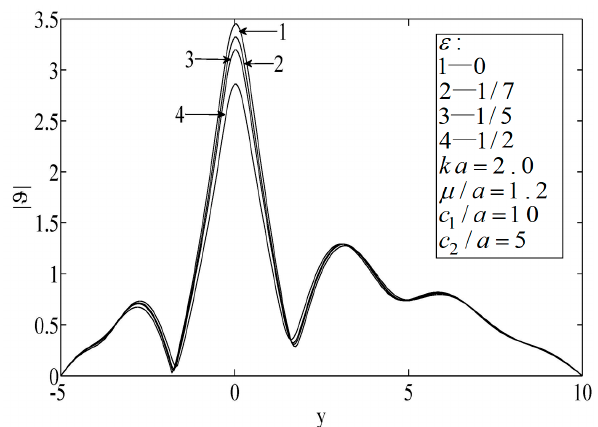
Figure 7. Temperature on the surfaces of the block.